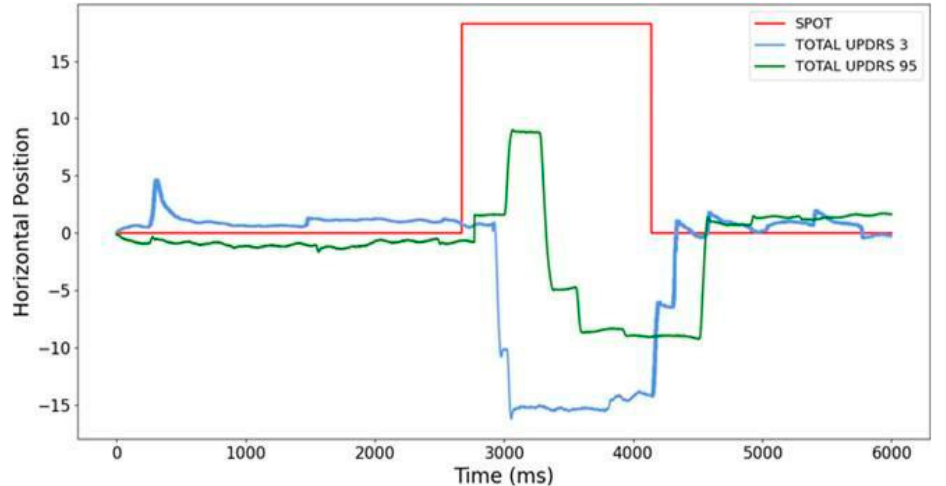
Figure 2. Antisaccades (AS) at various stages of PD. The red line is related to the light spot movements, and the blue and green curves are related to reflexive AS performed by two different PD patients in different stages of the disease: the blue curve denotes EM at the beginning of the disease, and the green curve in the advanced PD stage. Notice the significant difference not only in response latencies, but also in AS speed, and that a more advanced PD patient started with a saccade that changed to AS [21].